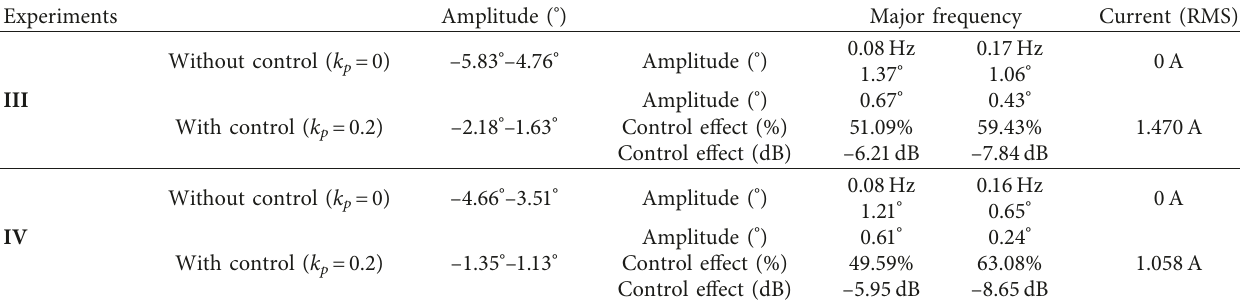
Table 7: Efficiencies of vibration control in the passive damping-based Experiments III and IV . Experiments Amplitude ( °